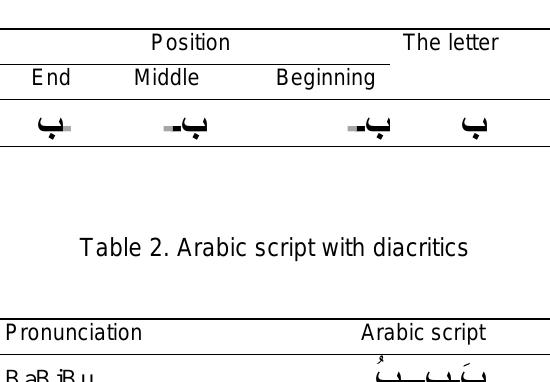
Table 1. Example of the three figures for the letter " ب "